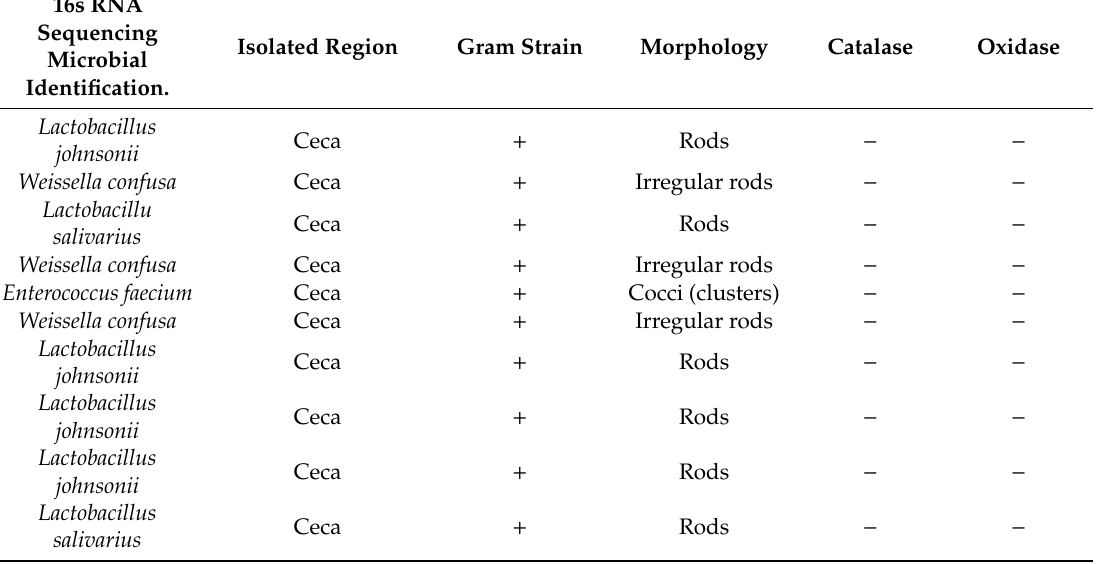
Table 1. Morphological characteristics and identification of lactic acid bacteria probiotic candidates